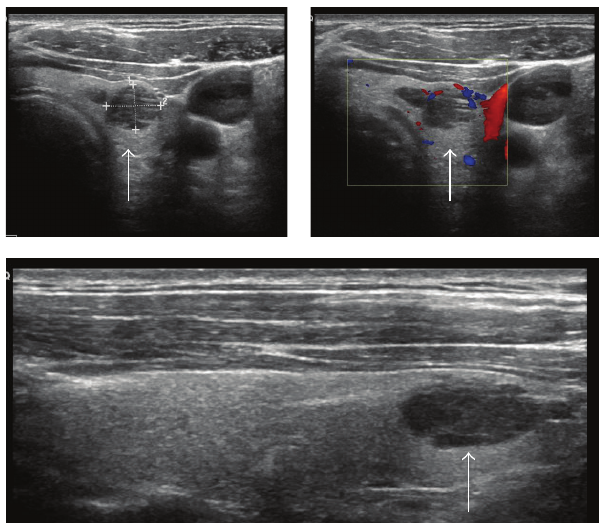
Figure 2: Ultrasound images of thyroid metastasis (identified by white